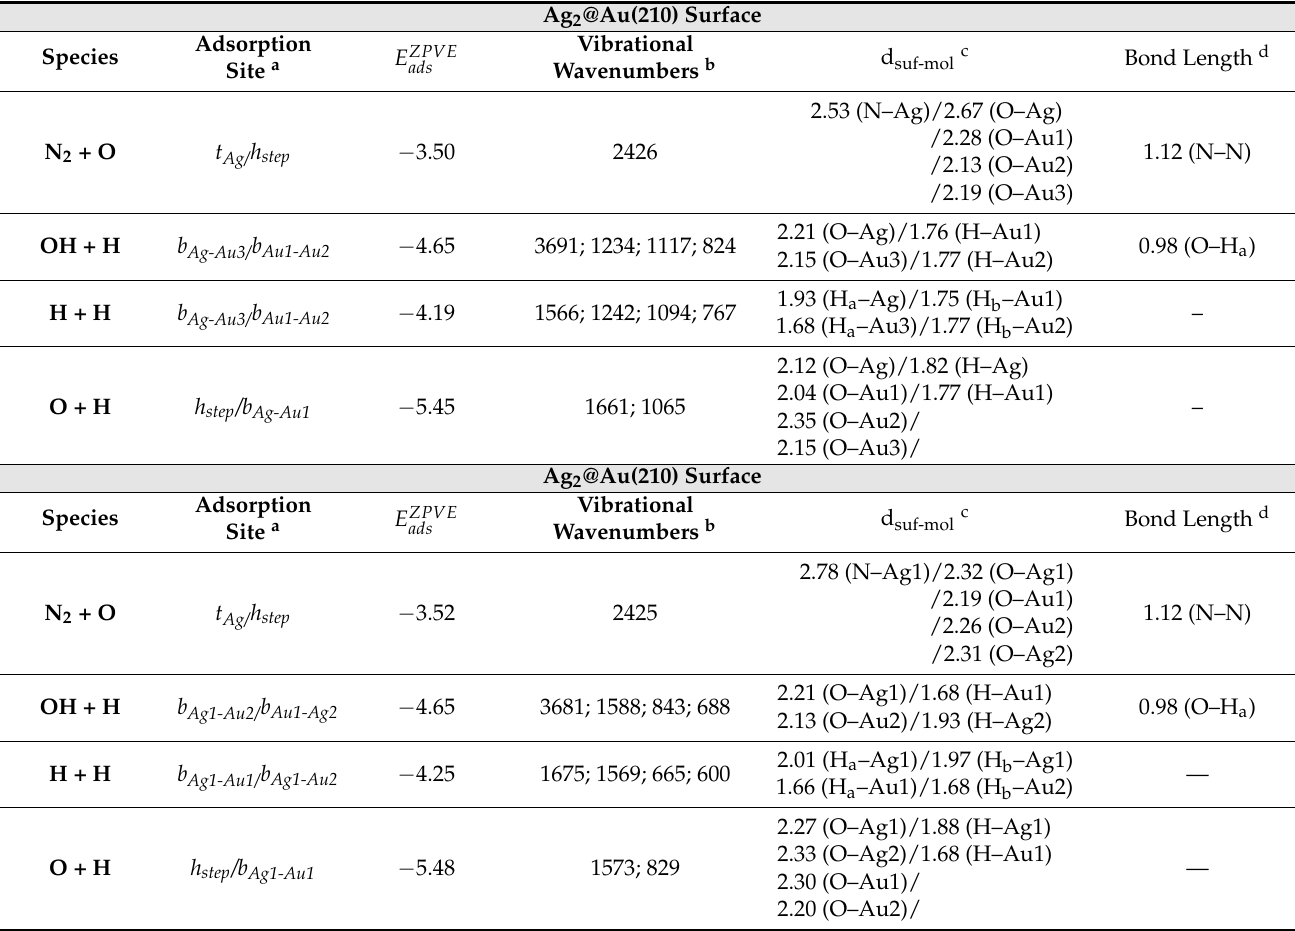
Table 2. Adsorption energies ( E ZPVE